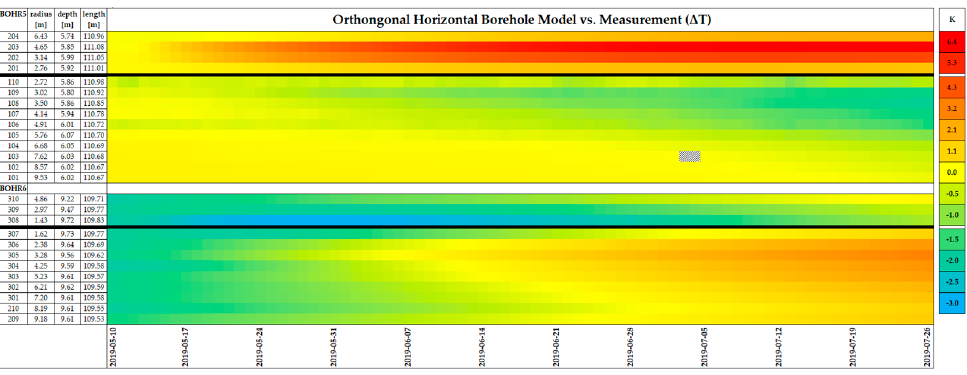
Figure 27. BOHR5 and BOHR6 modeled temperatures plotted against measured temperatures.